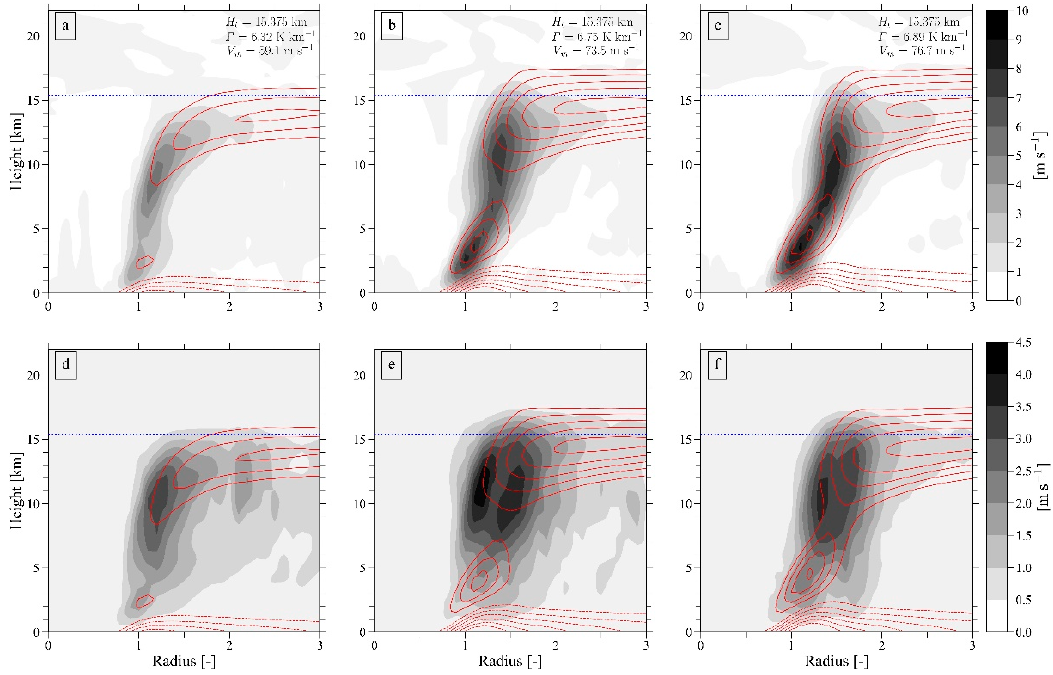
Figure 6. The same cross sections as Figure 5, except for ( a ) and ( d ) the cases with Γ being 6.32 K km − 1 , ( b ) and ( e ) CTL, and ( c ) and ( f ) the case with Γ being 6.89 K km − 1 .